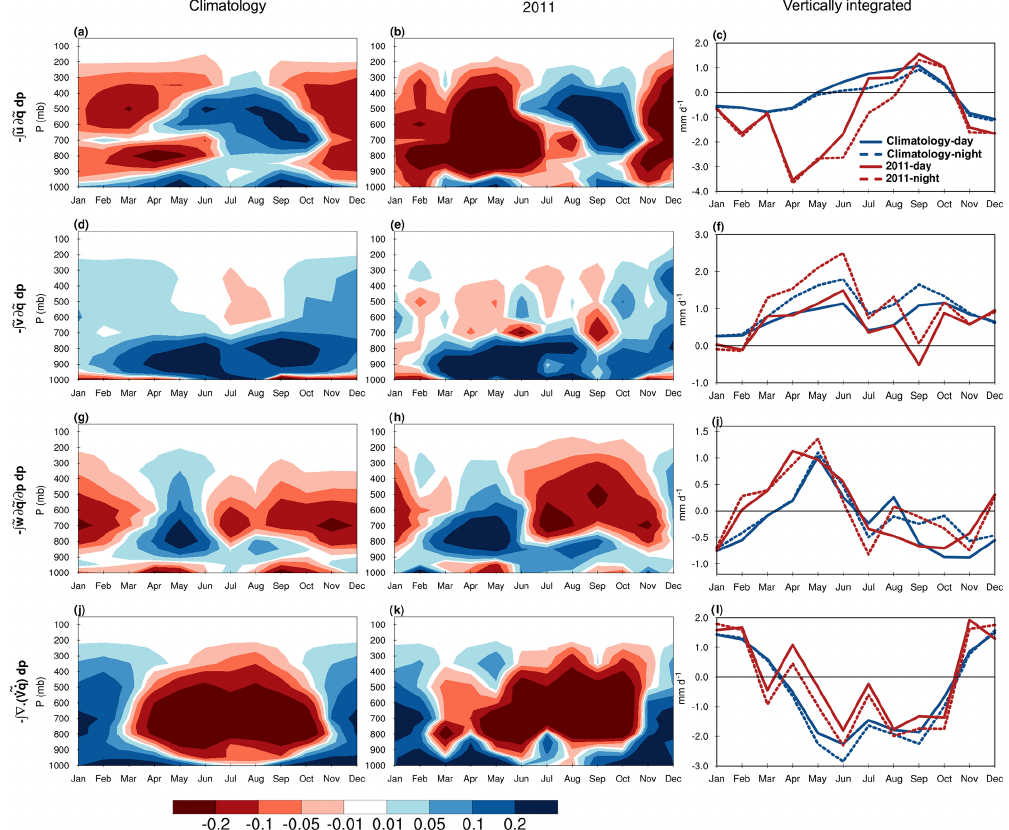
Figure 6. Hovmöller diagram of the vertical profile of the atmospheric moisture budget components averaged over the US southern Great Plains for the 1979–2018 climatology ( a , d , g , j ) and 2011 ( b , e , h , k ). The first to fourth rows respectively represent the zonal advection, meridional advection, vertical advection, and horizontal transient terms in millimeters per day (mmd − 1 ). The third column ( c , f , j , l ) repre- sents the annual cycle of the corresponding terms (vertically integrated) for the climatology (blue) and 2011 (red) during the daytime (solid) and nighttime (dashed) steps using 6-hourly ERA-Interim